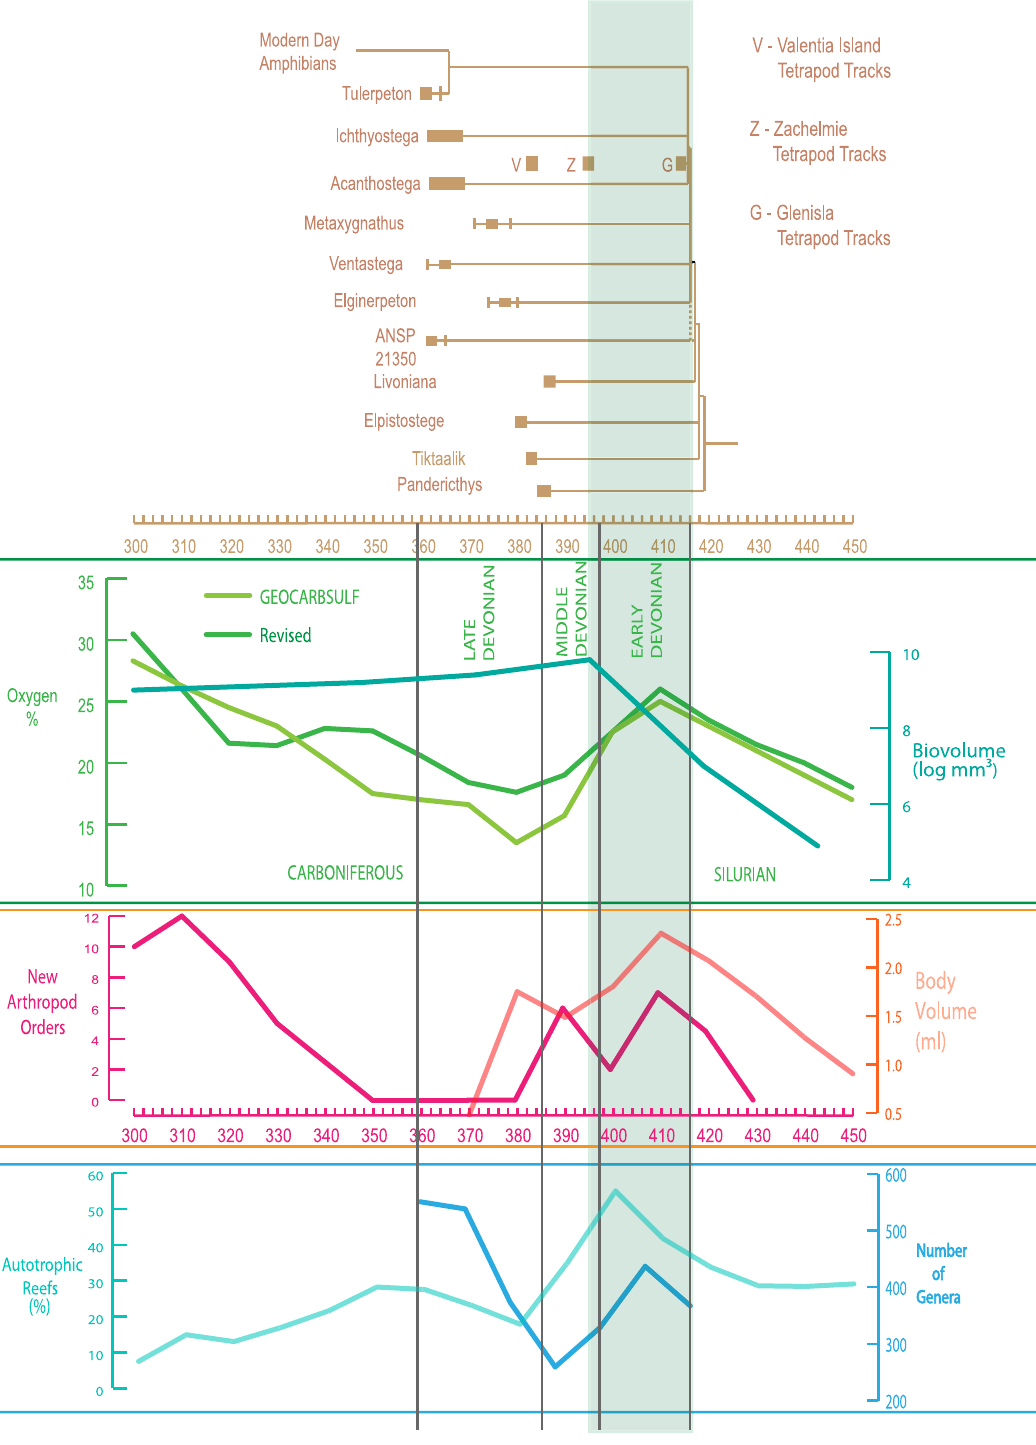
Figure 1. Genus-level biodiversity and phylogenetic relationships of elpistostegid fish and earliest tetrapods, as compared to abiotic and biotic features of Devonian environments. Due to the choosen phylogenetic scheme (after [11]), and the fact that we take into consideration the Glenisla trace fossils from Australia, ghost ranges of basal taxa (elpistostegids, from Panderichthys to Livoniana ) and tetrapods (from ANSP 21350 to the crown group ‘ Tulerpeton + modern amphibians’) are increased in a significant amount. We use oxygen levels predicted by GEOCARBSULF [21], evolution of arthropod orders [24], evolution of autotrophic reefs [27], body volume of marine invertebrates [26], and genus-level diversity of marine invertebrates [25]. It must be noted that in the highlighted zone of the diagram, the arthropods concerned with are three clades of terrestrial arthropods (myriapods, arachnids, hexapods). Hence the image gives a view of changes in terrestrial and marine species, but giving stress about the changes in marine environment since this is where the tetrapods evolved. The Zachelmie tracks [11] are quite close to the highlighted region and the Glenisla tracks [22] find a satisfactory position amongst the controversy in our image.